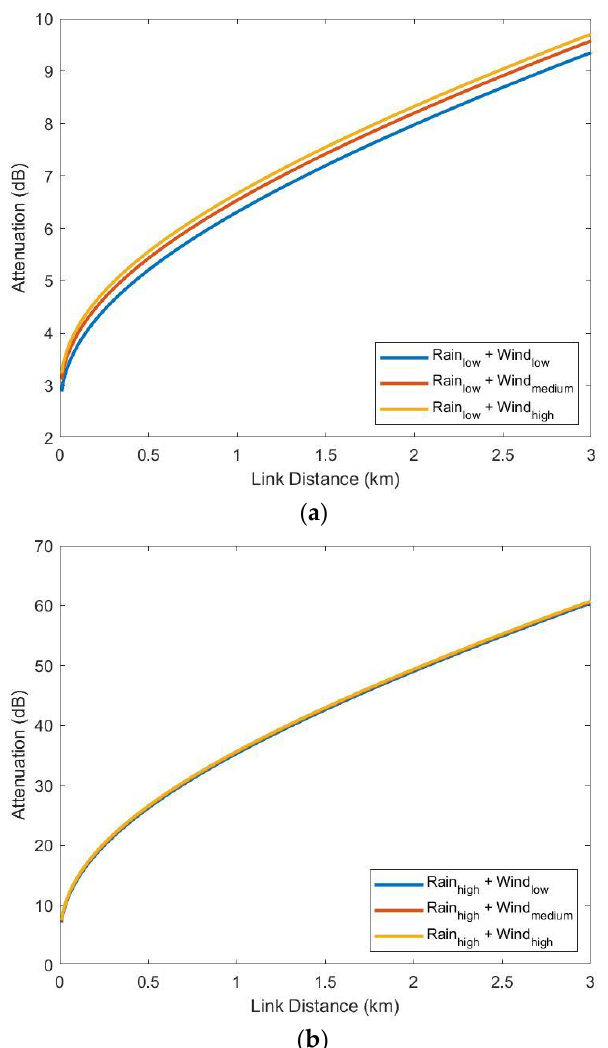
Figure 16. Expected attenuations as functions of the link distance under ( a ) low rain conditions and ( b ) high rain conditions.